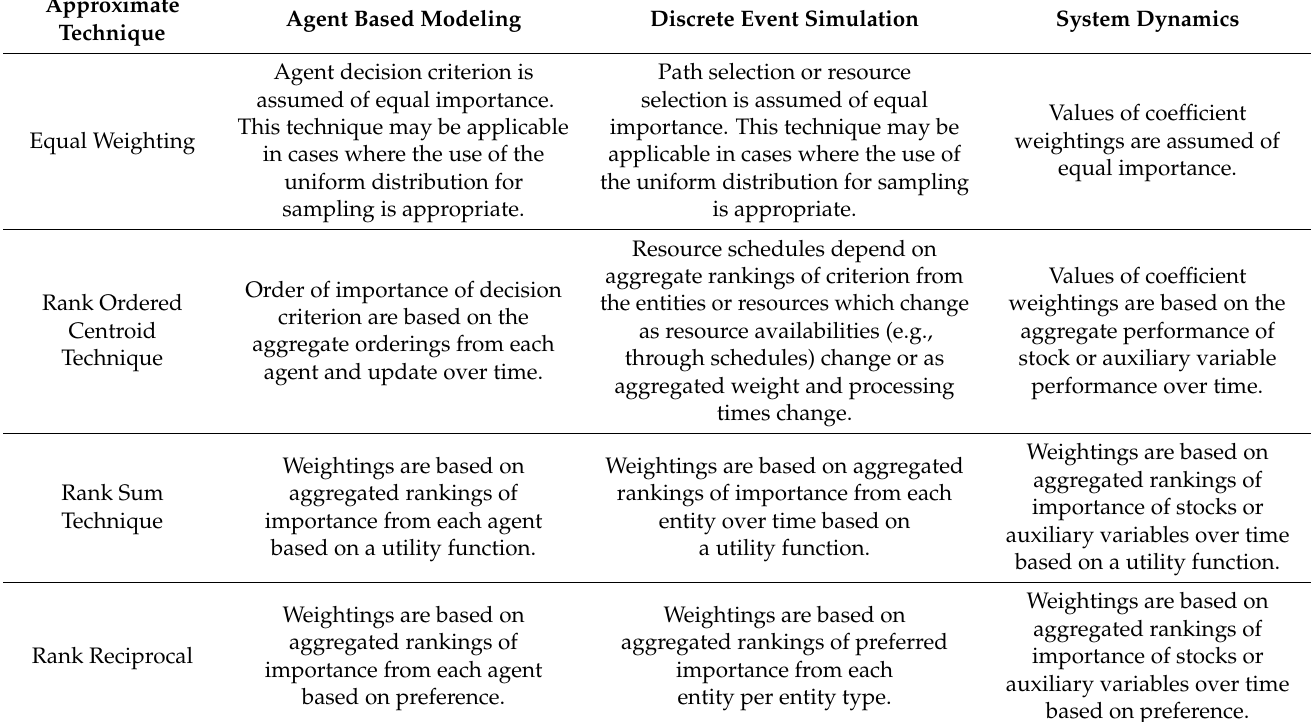
Table 19. Considerations for incorporating Approximate Techniques into ABM, DES, and SD modeling